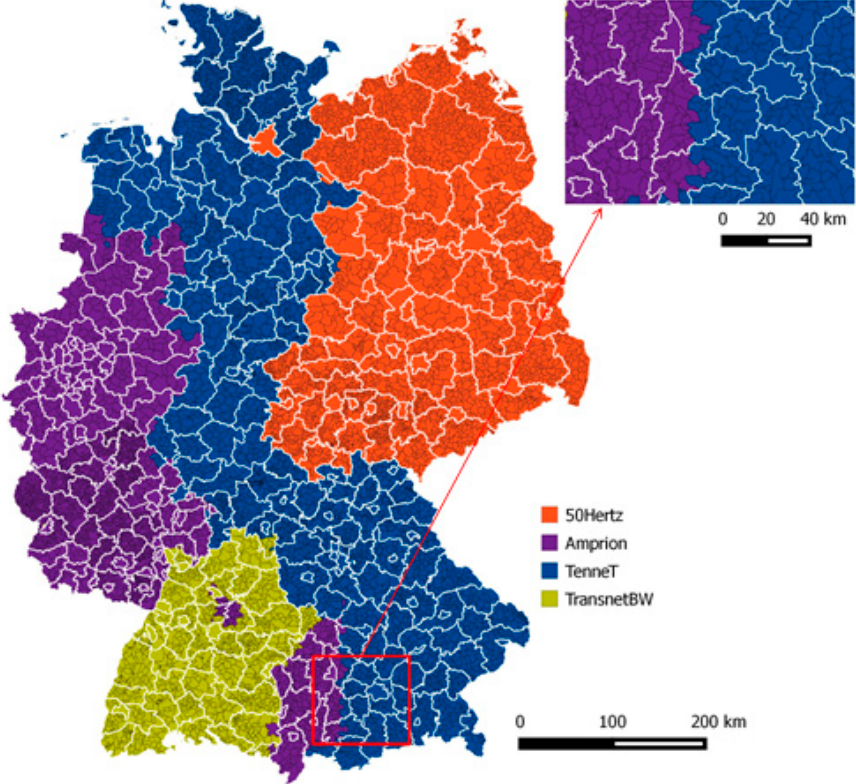
Figure 1. Germany’s TSOs: 50 Hertz, Amprion, TenneT and TransnetBW.